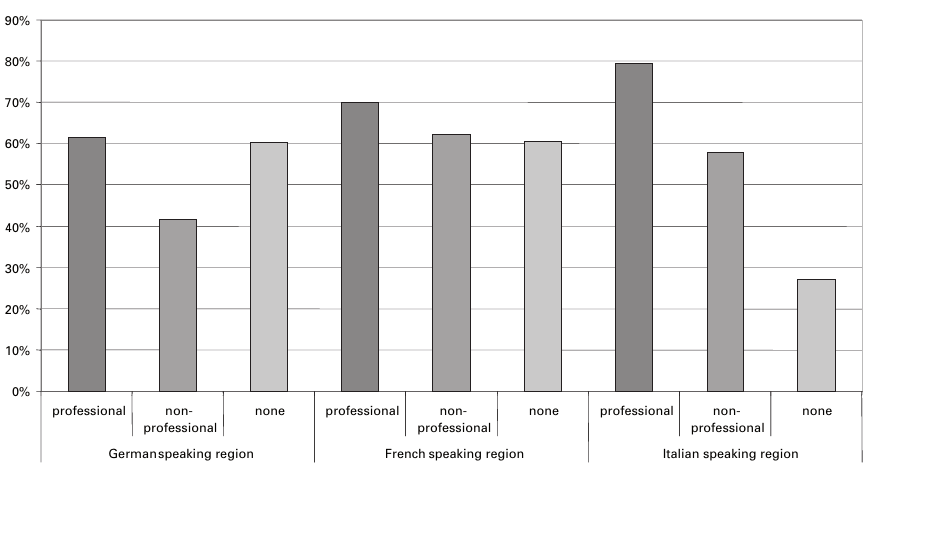
Figure 1 Adjusted* prevalence of vitamin D supple- mentation by source of information – stratified for language